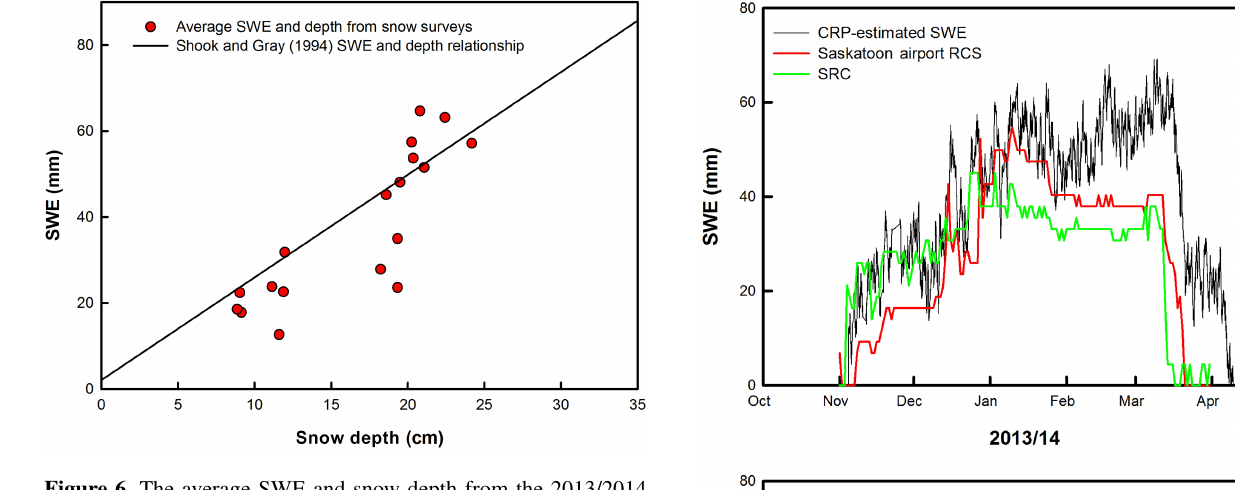
Figure 6. The average SWE and snow depth from the 2013/2014 and 2014/2015 snow surveys at the CRP study site. The black line represents the linear relationship between SWE and snow depth found by Shook and Gray (1994) for shallow (<60cm) snowpacks in the Canadian Prairies.